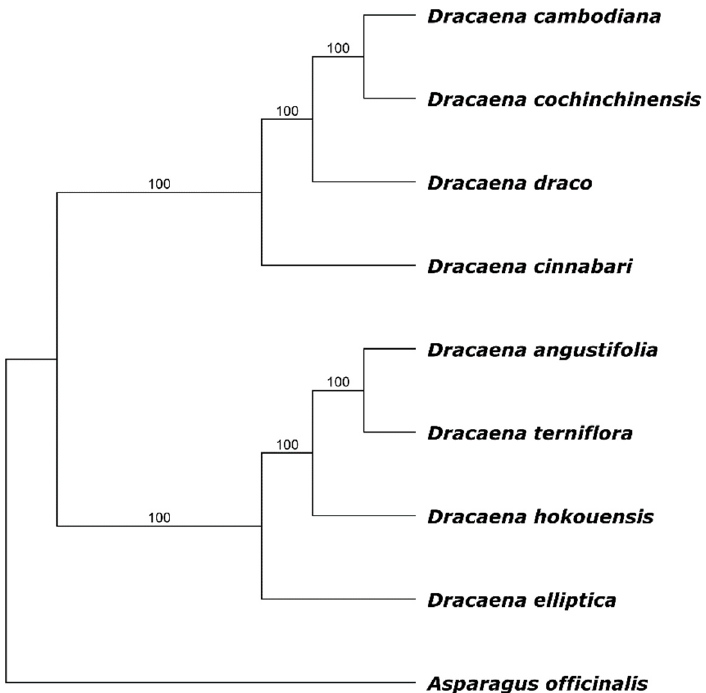
Figure 4. The ML phylogenetic tree of the Dracaena genus based on nine complete chloroplast genomes. The numbers near each node are bootstrap support values obtained by ML.